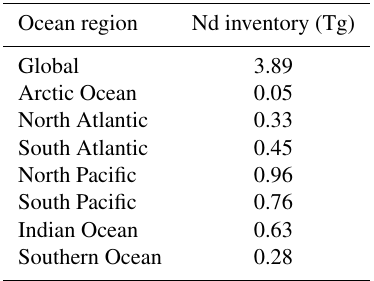
Table 4. Nd inventory (Tg) for EXPT_SED2 within different ocean